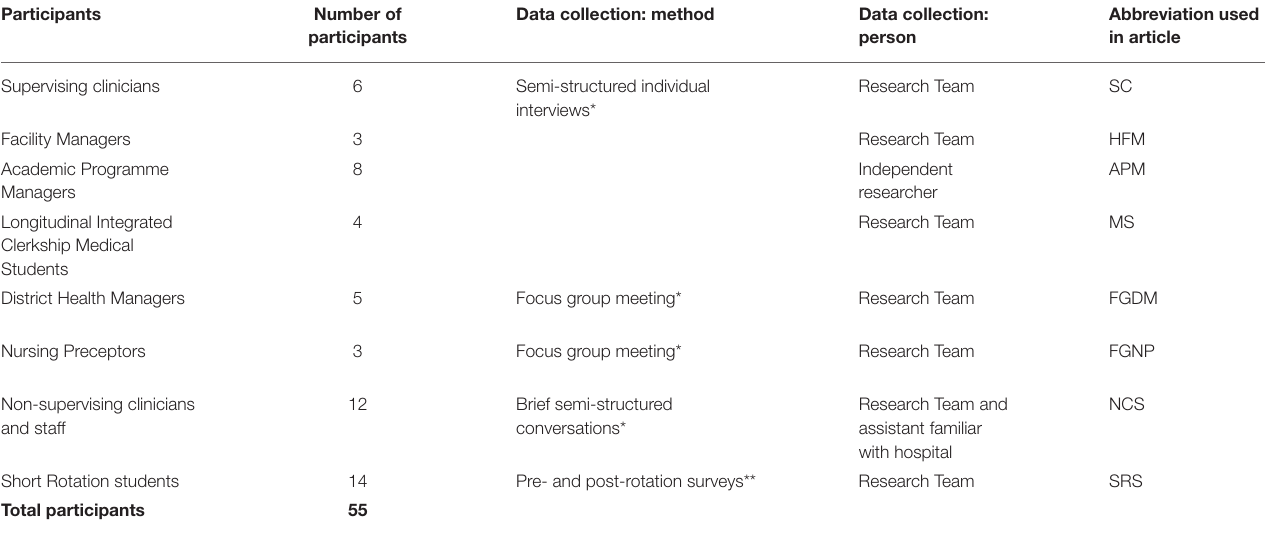
TABLE 1 | Summary of